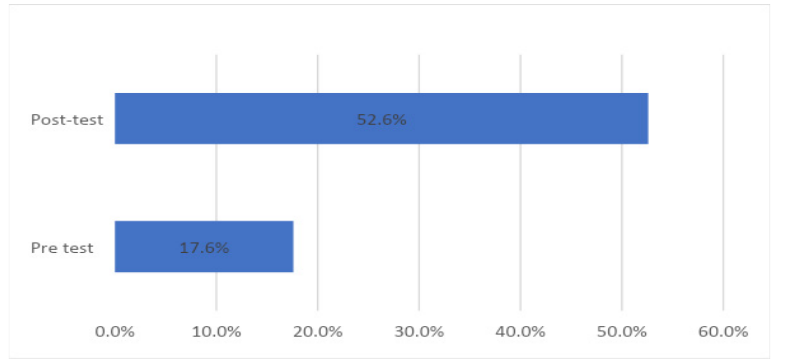
Figure 4 . Respondents’ mean score comparison .